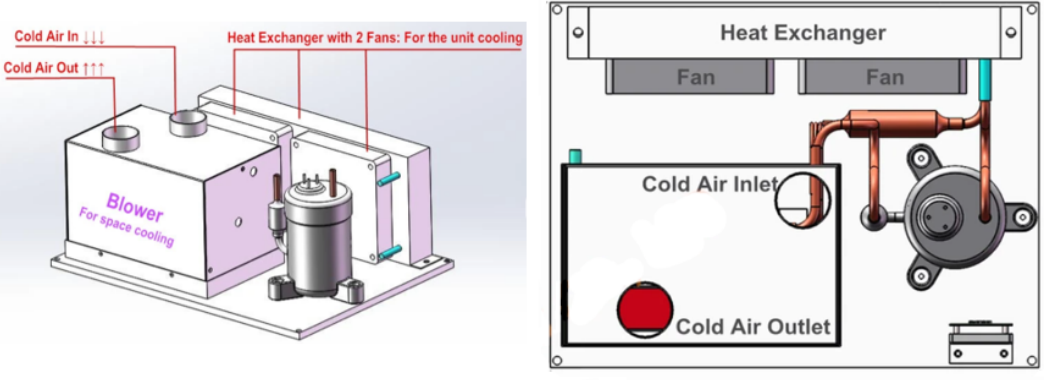
Figure 16. Micro DC Aircon